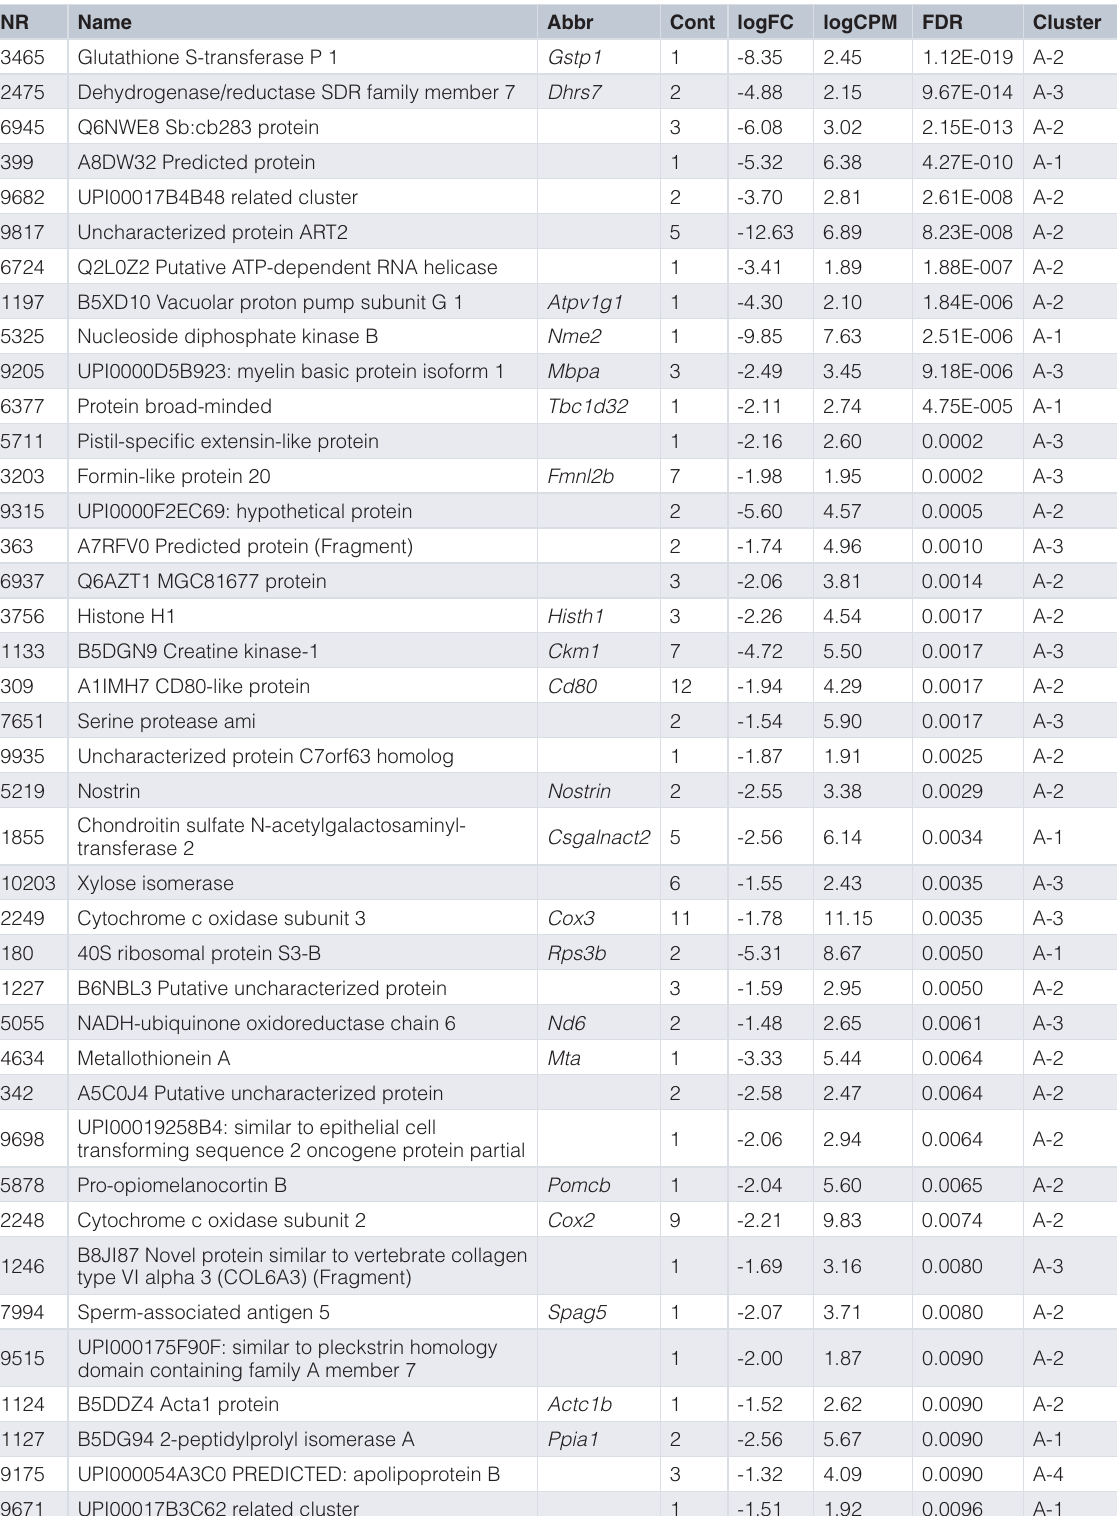
Table 2. Differentially expressed genes, with higher expression in the AC